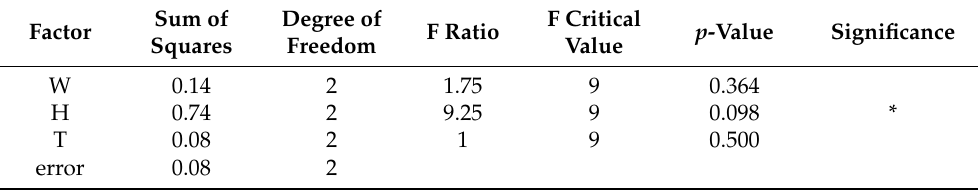
Table 15. The variance of the tangential swelling property of impregnated heat-treated wood. F Critical Sum of Degree of p -Value Significance F Ratio Factor Value Squares Freedom W 0.402